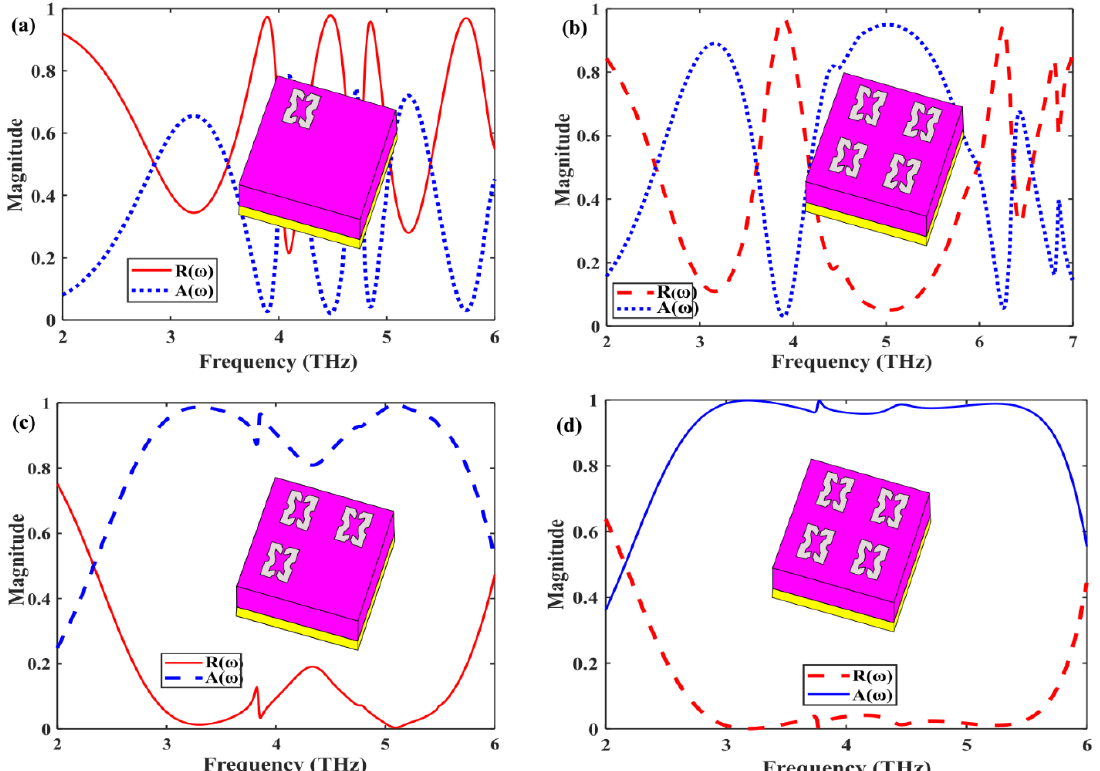
Figure 9. The structure’s reflections and absorption bands ( a ) with a single arc-shaped VO 2 patch on top; ( b ) with a two-arc VO 2 pattern on top; ( c ) with a three-arc VO 2 pattern on top; ( d ) with four equal arc-shaped VO 2 patterns positioned diagonally on the top.